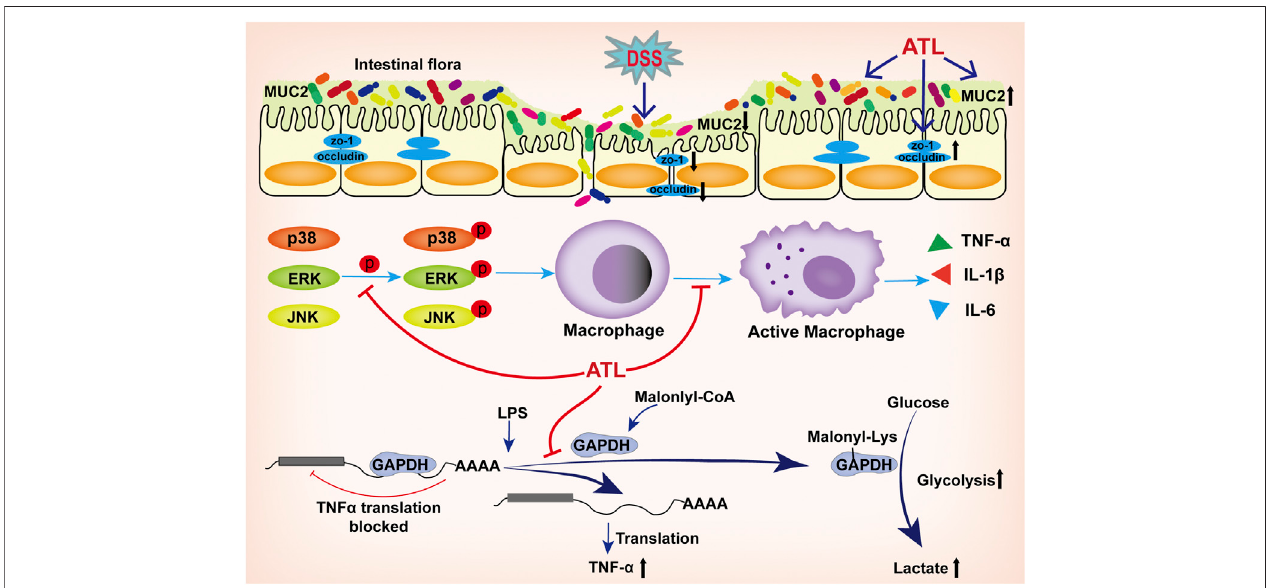
FIGURE7| Atractylodinattenuatesdextran sulfatesodium-induced colitisbyalleviatinggutmicrobiota dysbiosisandinhibitingin fl ammatoryresponsethroughthe MAPK pathway. The mechanism could likely be attributed to the effect of atractylodin in inhibiting the MAPK pathway; inhibiting the activation of macrophages in colon tissue; inhibiting the decrease in tight junction proteins, ZO-1, occludin, and MUC2 to protect the intestinal barrier; decreasing the abundance of harmful bacteria and increasing that of bene fi cial bacteria, thereby improving the overall intestinal micro fl ora. In vitro experiments revealed that atractylodin could inhibit the MAPK pathway and macrophage activation. Atractylodin could not inhibit the transcription of TNF- α but could inhibit its translation, which might be related to its effect of inhibiting the malonylation of the GAPDH protein.